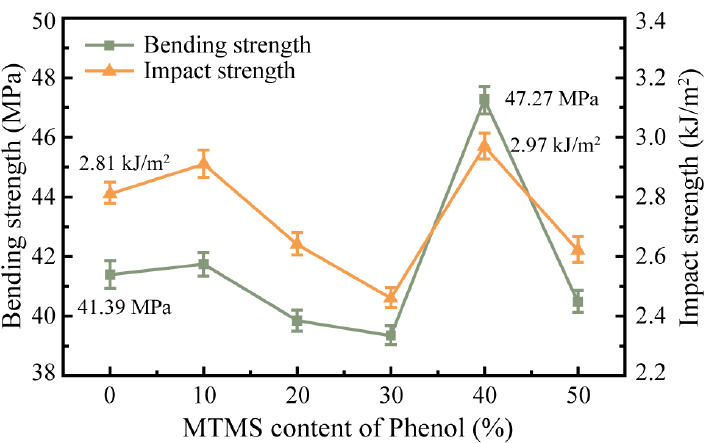
Figure 11. Bending strength and impact strength of phenolic resin modified with different content of MTMS. of